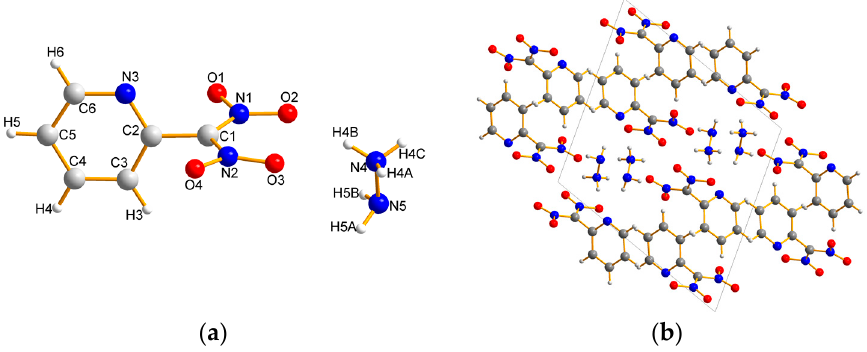
Figure 5. ( a ) Molecular structure of 4 ; ( b ) packing diagram of 4 viewed down the b-axis.